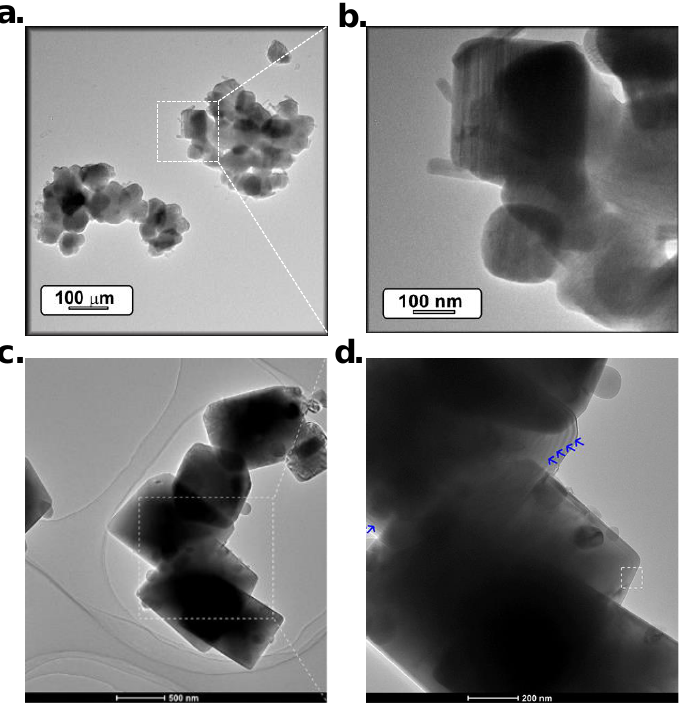
Figure 4. ( a , b ) Low- and high-magnification TEM characterization of particles based on SrAl 2 O 4 :Eu, Dy synthesized at 900 °C. ( c , d ) TEM images of particles based on MgAl 2 O 4 :Mn 4+ . Reprinted with permission from [30]. Copyright 2020, American Chemical Society Publishing.